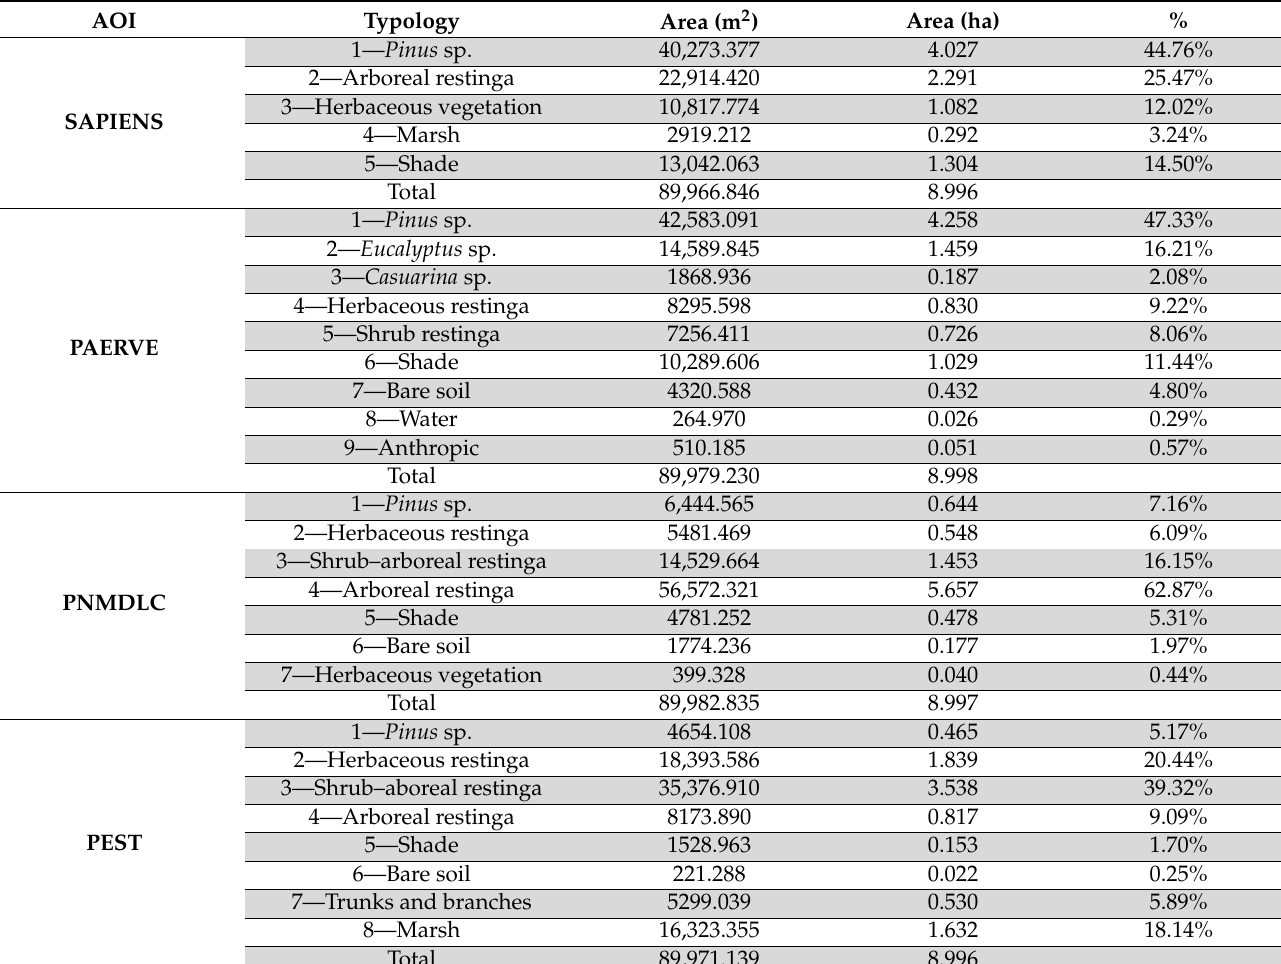
Table 13. Area calculations by classified